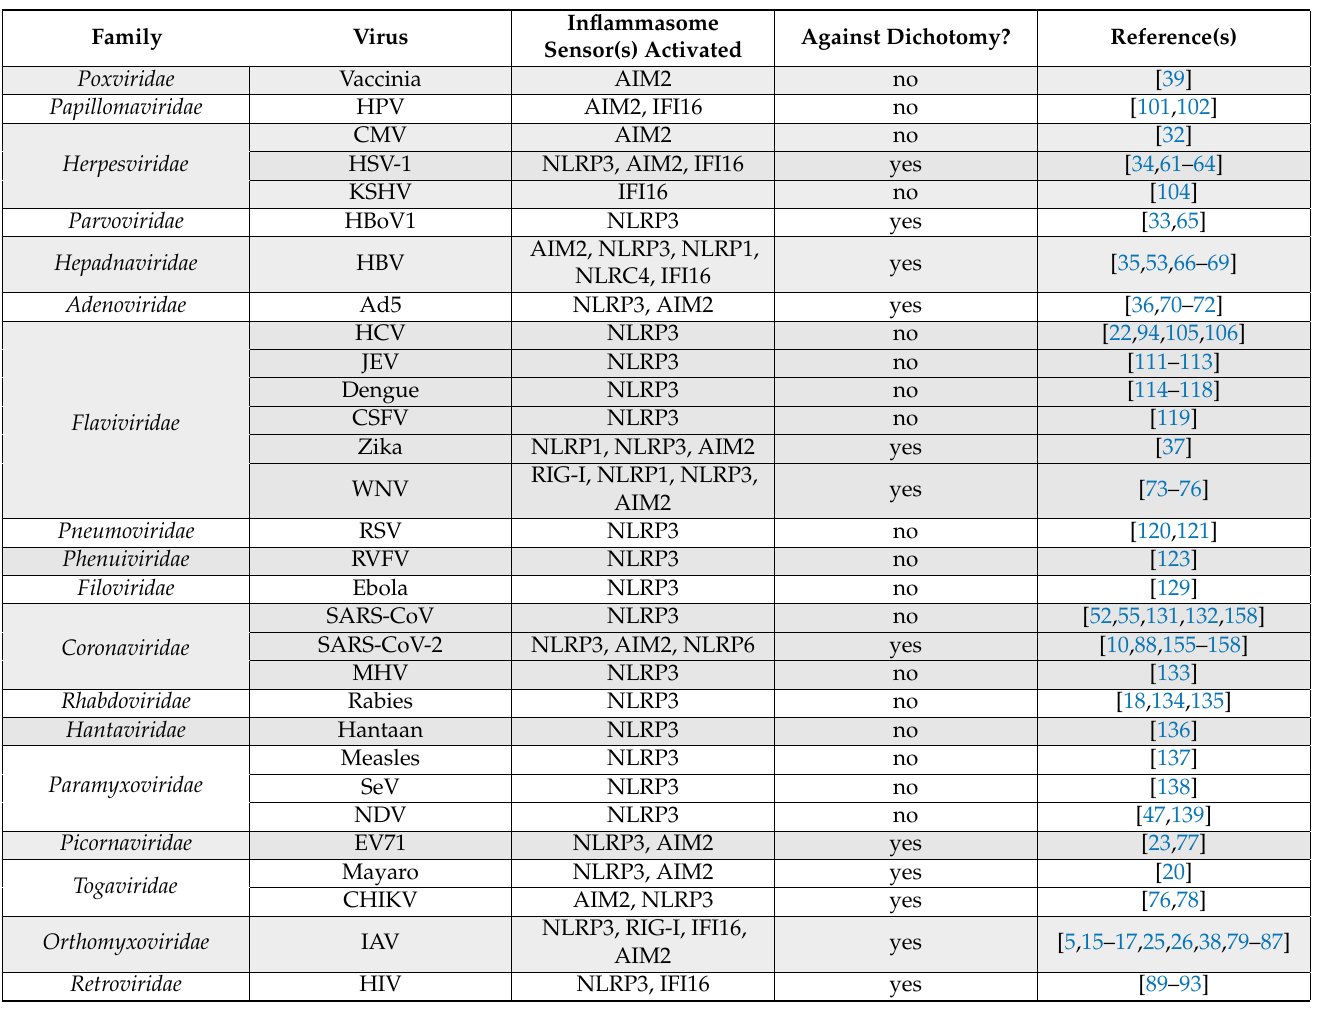
Table 1. Viruses, separated by family, with inflammasome sensors activated and references associated with each